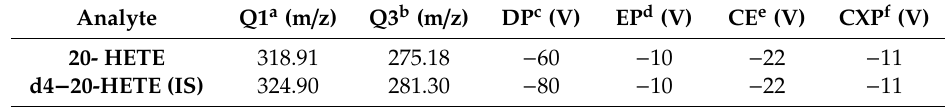
Table 1. LC-MS / MS parameters selected for the quantification of 20 HETE and d4-20 HETE (IS). Analyte Q1 a (m / z) Q3 b (m / z) DP c (V) 20- HETE 318.91 275.18 324.90